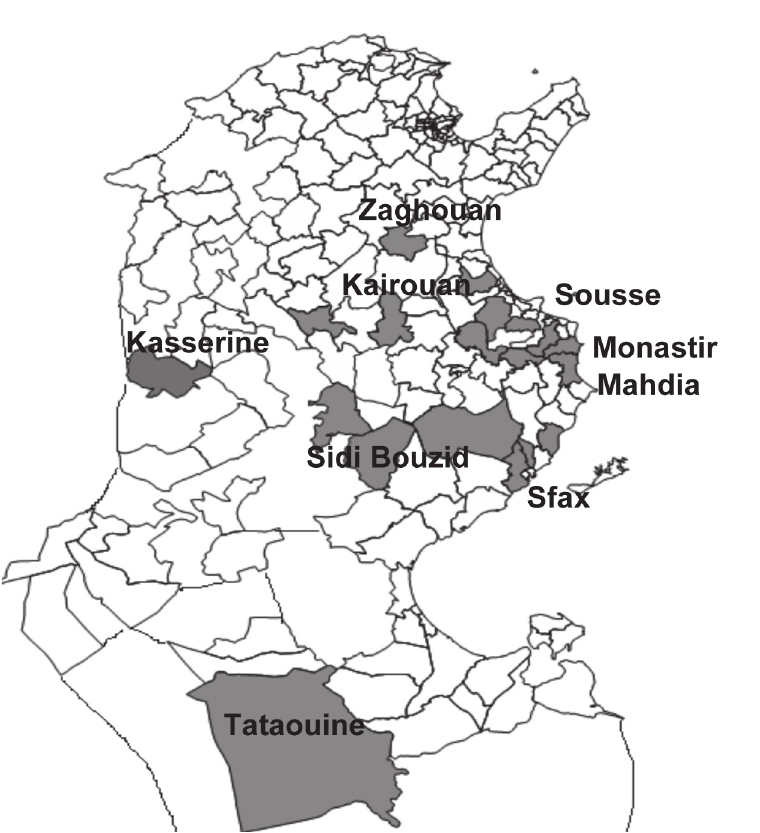
Figure 1. Localities of the olive tree orchards in Tunisian regions showing symptoms of Verticillium